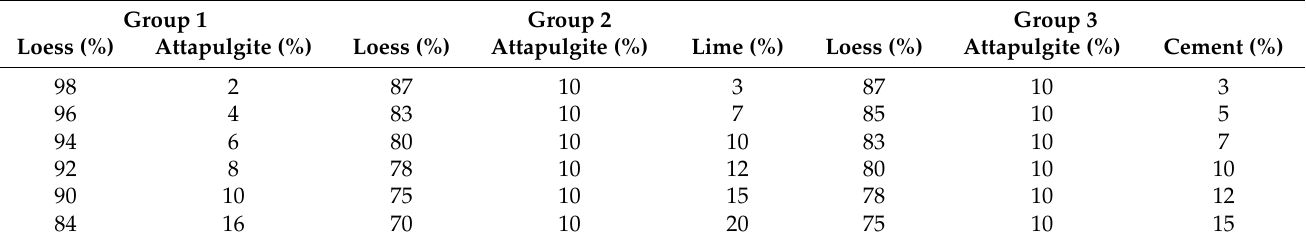
Table 4. Loess modification mixtures composition divided into three main groups.